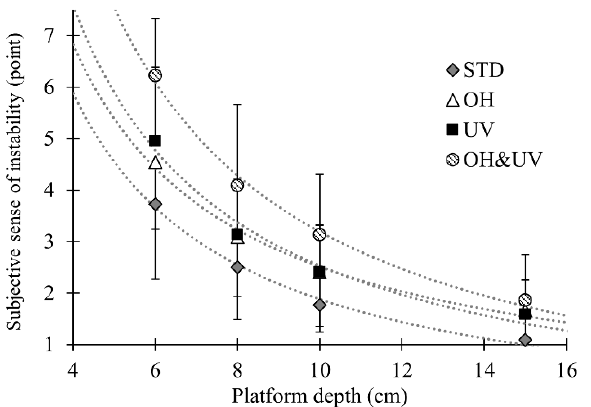
Figure 9. Subjective sense of instability as a function of the platform depth. Dotted lines show the approximate curves for the reciprocal of the platform depth ( y = a / d + b ). For coefficients of the fitting functions and the significance test of the regression model, see Appendix A.